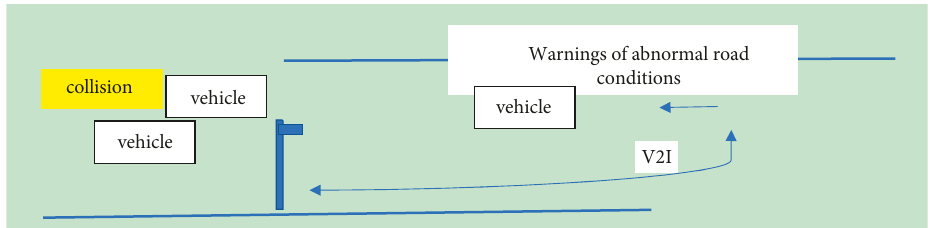
Figure 10: Scene of V2V-based abnormal road condition